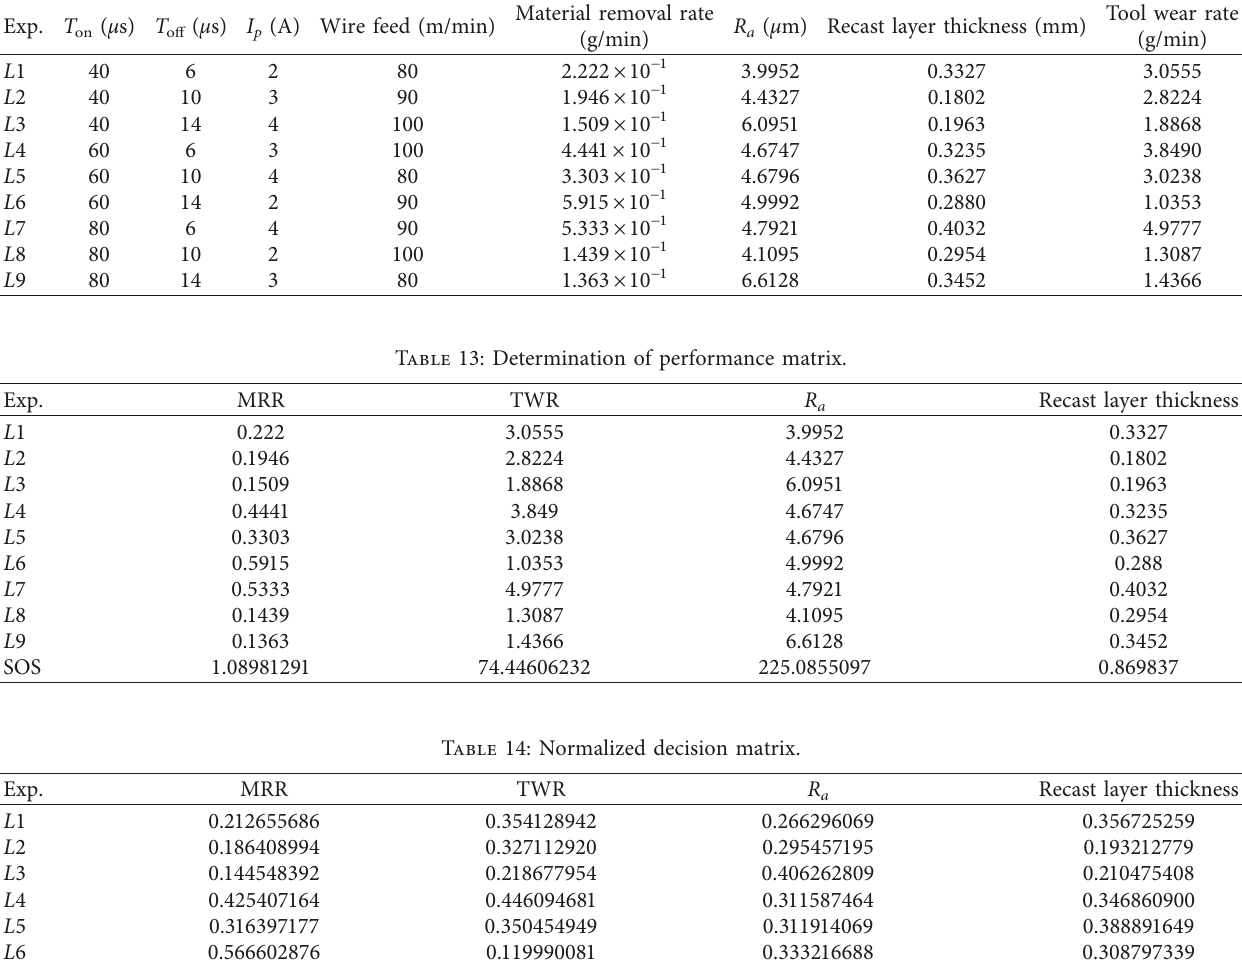
Table 12: Design of experiments using zinc-coated brass wire as a tool.